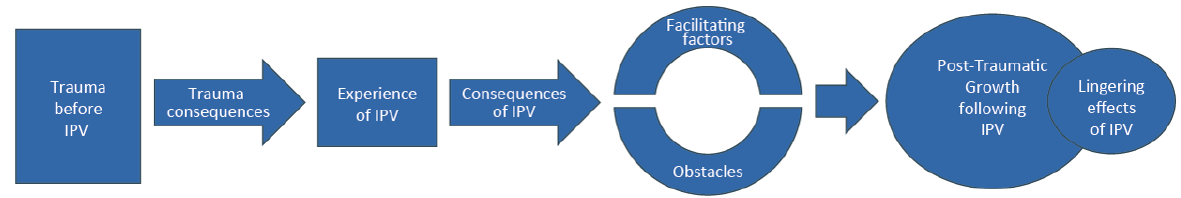
Figure 1. The eight main components of the post-traumatic growth journey by female survivors of intimate partner violence. Note . The figure, developed by the authors for the present theory, introduces the eight main components of the PTG journey as experienced by female IPV survivors. 1.